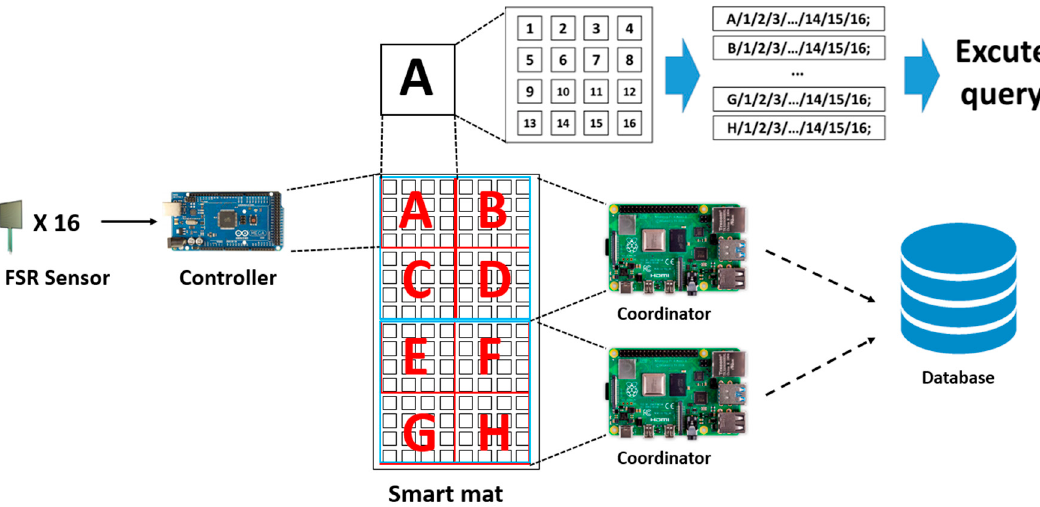
Figure 2. The hardware architecture of the smart mat system.